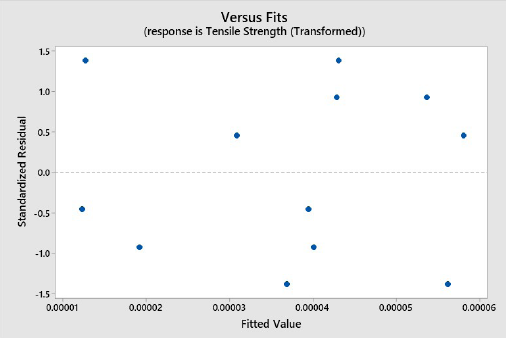
Figure 3. The plot of the residual versus fit for the tensile